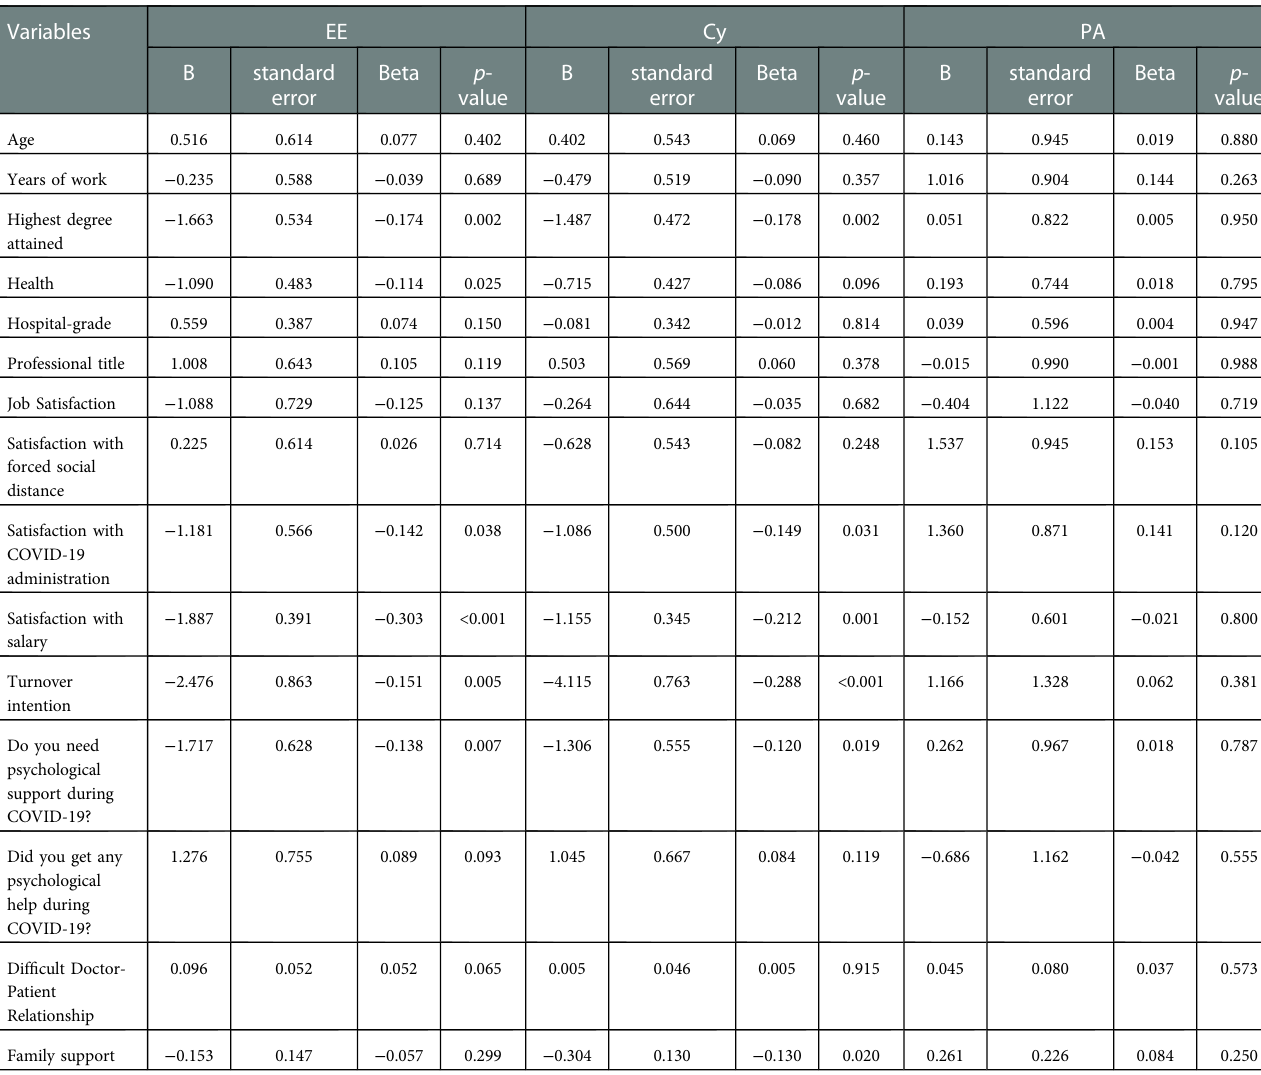
TABLE 5 Multiple regression analysis of the factors associated with BOS.